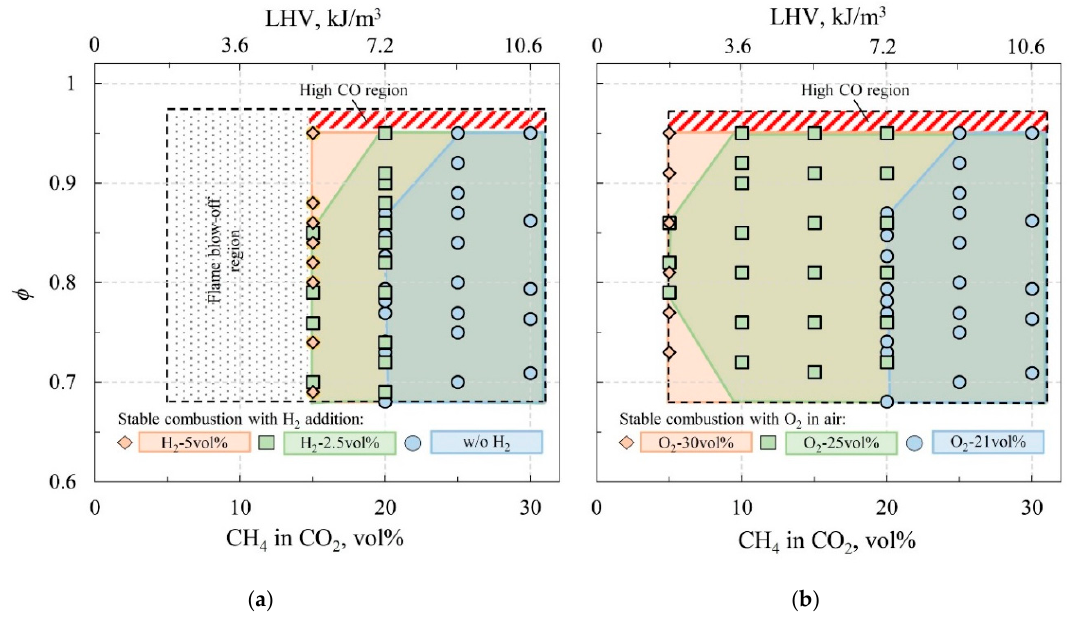
Figure 3. Stability maps of waste biogas (LCV) combustion with different content of CH 4 in CO 2 for a range of ( a )H 2 addition and ( b ) O 2 air enrichment.